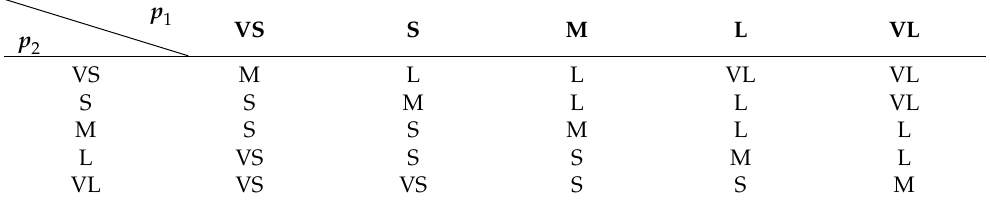
Table 3. Fuzzy rule table for determining the degree to which a specified crop is selected as a candidate